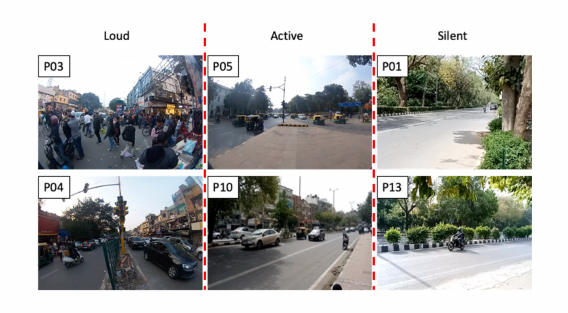
Figure 4: Representative images for three